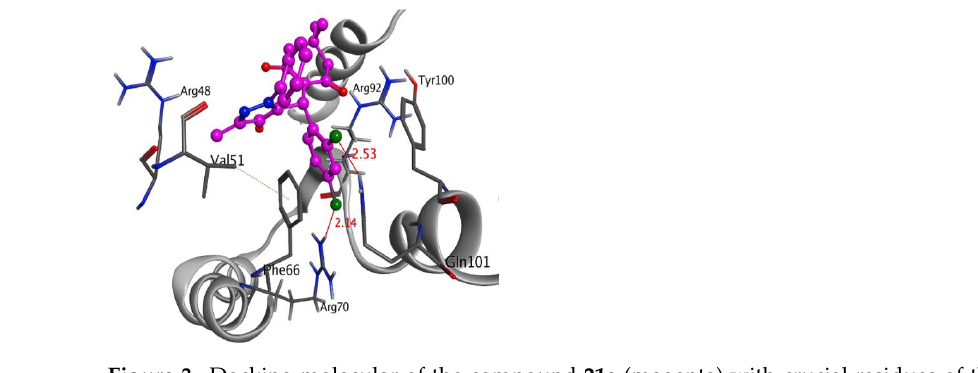
kinase target protein (PDB ID: 4QGG) from Staphylococcus aureus . Image adapted from Barakat et al. [31].